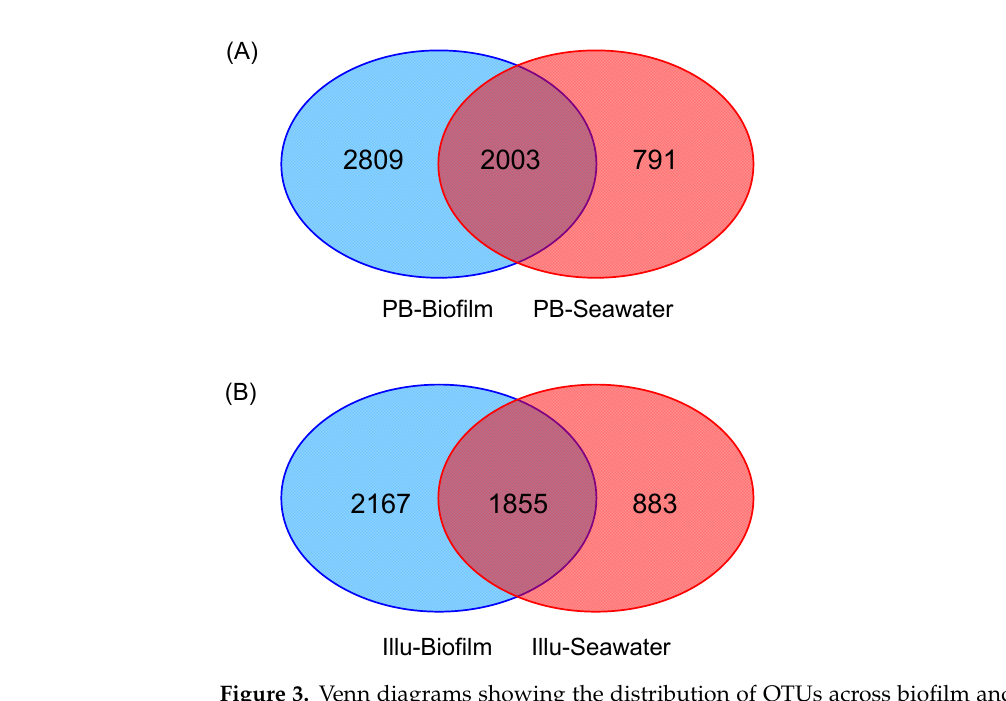
6 of 13 Figure 2. Principal coordinate analysis (PCoA) based on OTU compositions of biofilms and seawater communities. Bray–Curtis distances were used in the calculation. PB-Biofilm and PB-Seawater rep- resent the three biofilm and three seawater samples sequenced by PacBio, respectively. Illu-Biofilm and Illu-Seawater represent the same samples sequenced by Illumina. 3.3. Venn Analysis To further visualize the dissimilarity between biofilm and seawater samples, a Venn analysis was conducted. OTUs from the three PB-Biofilms were pooled to compare with the three combined PB-Seawater samples. As shown by the results, 2003 (35.75%) OTUs were shared by the biofilm and seawater groups, while 2809 (50.13%) and 791 OTUs (14.12%) were specific to the biofilm group and seawater group, respectively (Figure 3A).